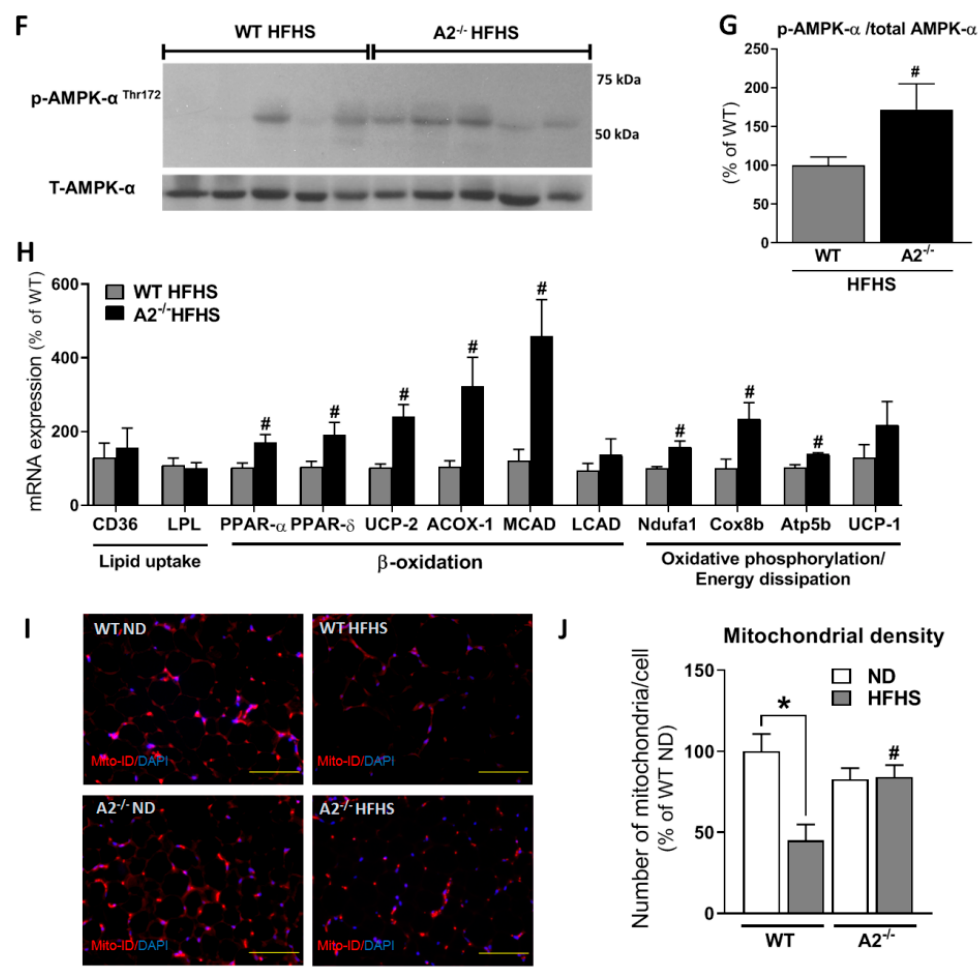
Figure 6. A2 deletion enhanced adipocyte expression of genes involved in fatty acid metabolism and preserved mitochondrial density. Representative western blot ( A ) and densitometry analysis normalized to the loading control ( β -Actin) ( B ) showing adiponectin protein levels in VAT, n = 3–4/group. Adipocyte mRNA expression of adiponectin ( C ), n = 5–7/group. Adipocyte mRNA expression of PGC-1 α ( D ) and PPAR- γ ( E ), n = 5–8 per group. Representative western blot ( F ) and densitometry analysis ( G ) showing ratio of p-AMPK- α to total- AMPK- α in VAT, n = 5–8/group and mRNA expression of genes involved in fatty acid uptake, β -oxidation and oxidative phosphorylation (OXPHOS), n = 4–6 ( H ). Immunofluorescence images of VAT sections stained with MitoID-Red as an estimate of mitochondrial mass ( I ) with quantitation ( J ); scale bar = 50 µ M. Values are means ± SEM; * P < 0.05 when compared to ND-fed mice within the same genotype, # P < 0.05 when compared to WT on the same diet.